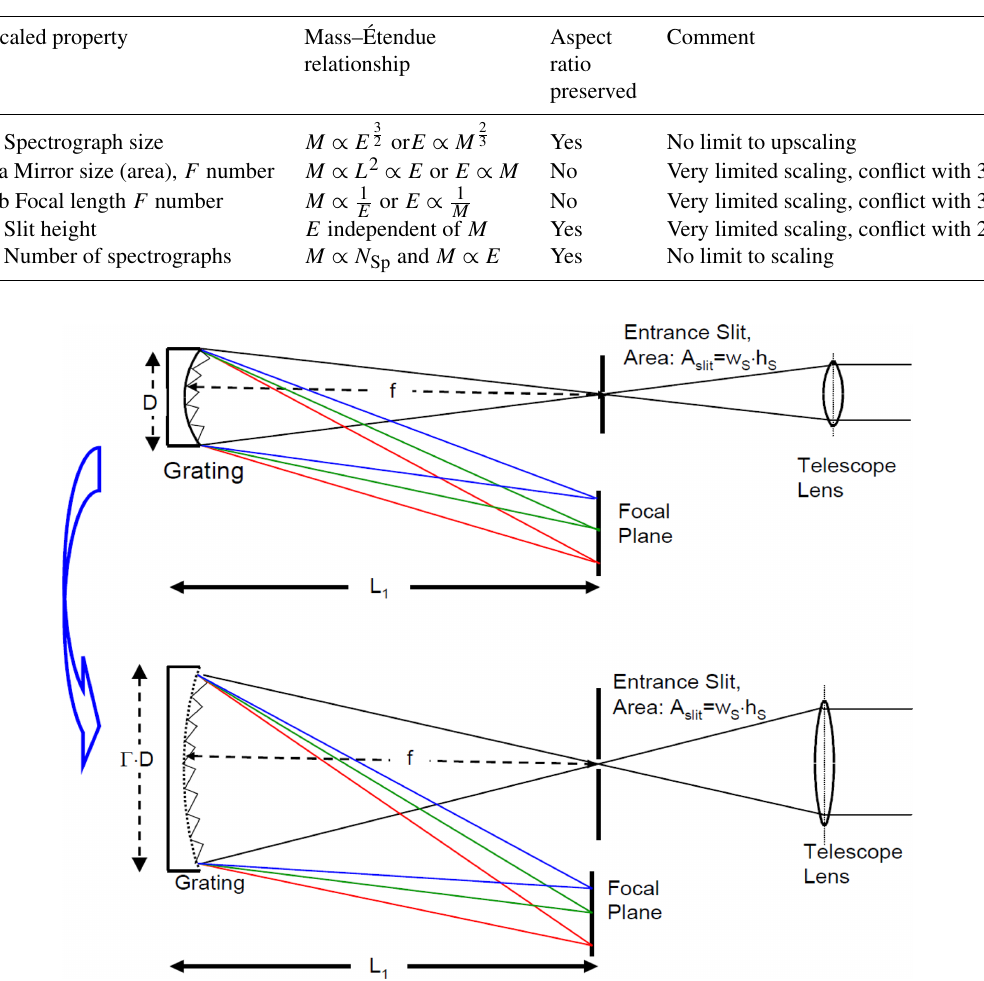
Figure 3. Scaling the spectrograph (plus telescope) F number, option a: scale size (i.e. diameter) of the optics D with the linear scaling factor (cid:48) , while focal length and slit dimensions, i.e. slit width (extension in dispersion direction) and slit height (extension perpendicular to the dispersion direction), are